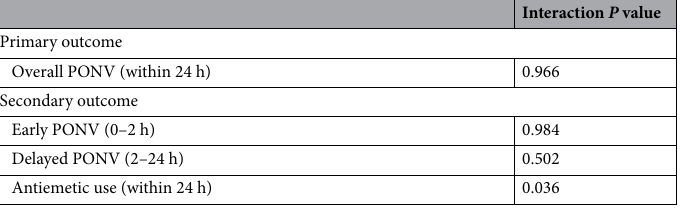
Table 3. Interaction of primary and secondary outcomes between the use of sugammadex (vs neostigmine) and total intravenous anesthesia (vs inhalation anesthesia). PONV postoperative nausea and vomiting.